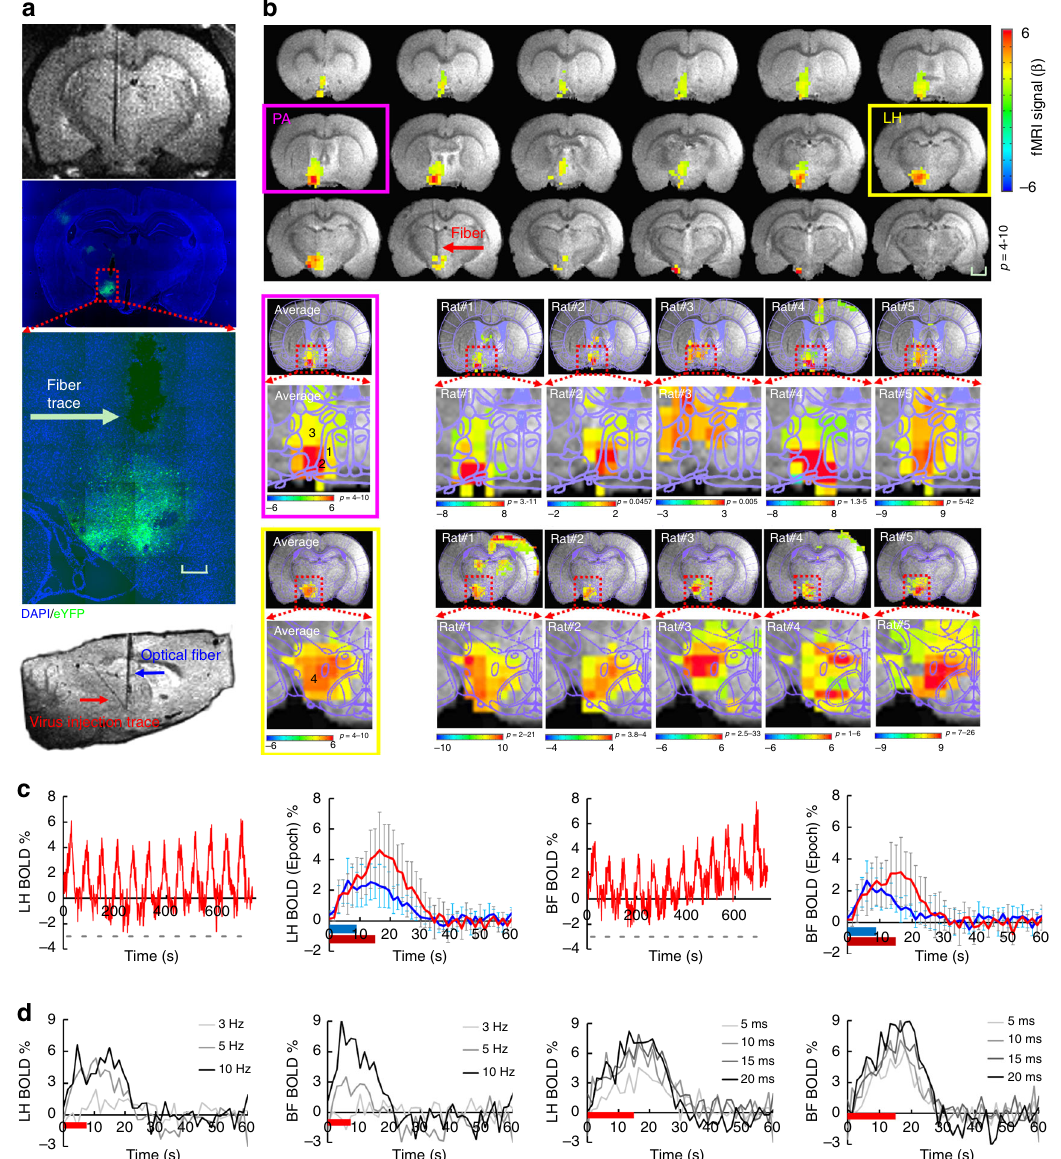
Fig. 3 MgRA-driven fi ber optic targeting of the lateral hypothalamic nuclei with optogenetic fMRI. a Top: representative RARE anatomical image used to clarify the optical fi ber location driven by MgRA for optical stimulation in LH. Middle: representative wide- fi eld fl uorescence image illustrating robust ChR2- eYFP expression focused on LH. Fiber optic insertion trace marked with white arrow. Scale bar, 200 µ m. Bottom: sagittal RARE anatomical image showing the fi ber optic trace (blue arrow) and virus injection trace (red arrow). b Top: average fMRI map of brain-wide activity during optogenetic stimulation of LH neurons at 5 Hz, 20 ms pulse width, 15 s duration. Middle: averaged evoked BOLD map (left) and the same map from 5 individual rats (right) zoomed in on the basal forebrain (BF) showing activation of the lateral preoptic nucleus (LPO) and medial preoptic area (MPA), overlaid with the brain atlas. Bottom: average evoked BOLD map (left) and 5 individual rats (right) in lateral hypothalamic region, overlaid with the brain atlas. GLM-based t -statistics in AFNI is used. Scale bar, 2 mm. c Average time courses of signi fi cantly modulated voxels showing fMRI signal changes within the ipsilateral LH and BF ( n = 5 animals) upon optogenetic stimulation of block design: 15 s on/45 s off, 12 epoch, 20 ms light pulse, 5 Hz, 18.9 mW. The individual hemodynamic response shows the average BOLD signal upon different stimulation durations (8 s in blue, 15 s in red). Error bars represent mean ± SD across 5 animals. d Average stimulation duration-locked time evolution for both LH and BF depicting the frequency-dependent hemodynamic responses at 3, 5, and 10 Hz with 8 s stimulus duration, as well as pulse-width-dependent hemodynamic responses at 5, 10, 15, and 20 ms with 15 s stimulus duration, from one representative